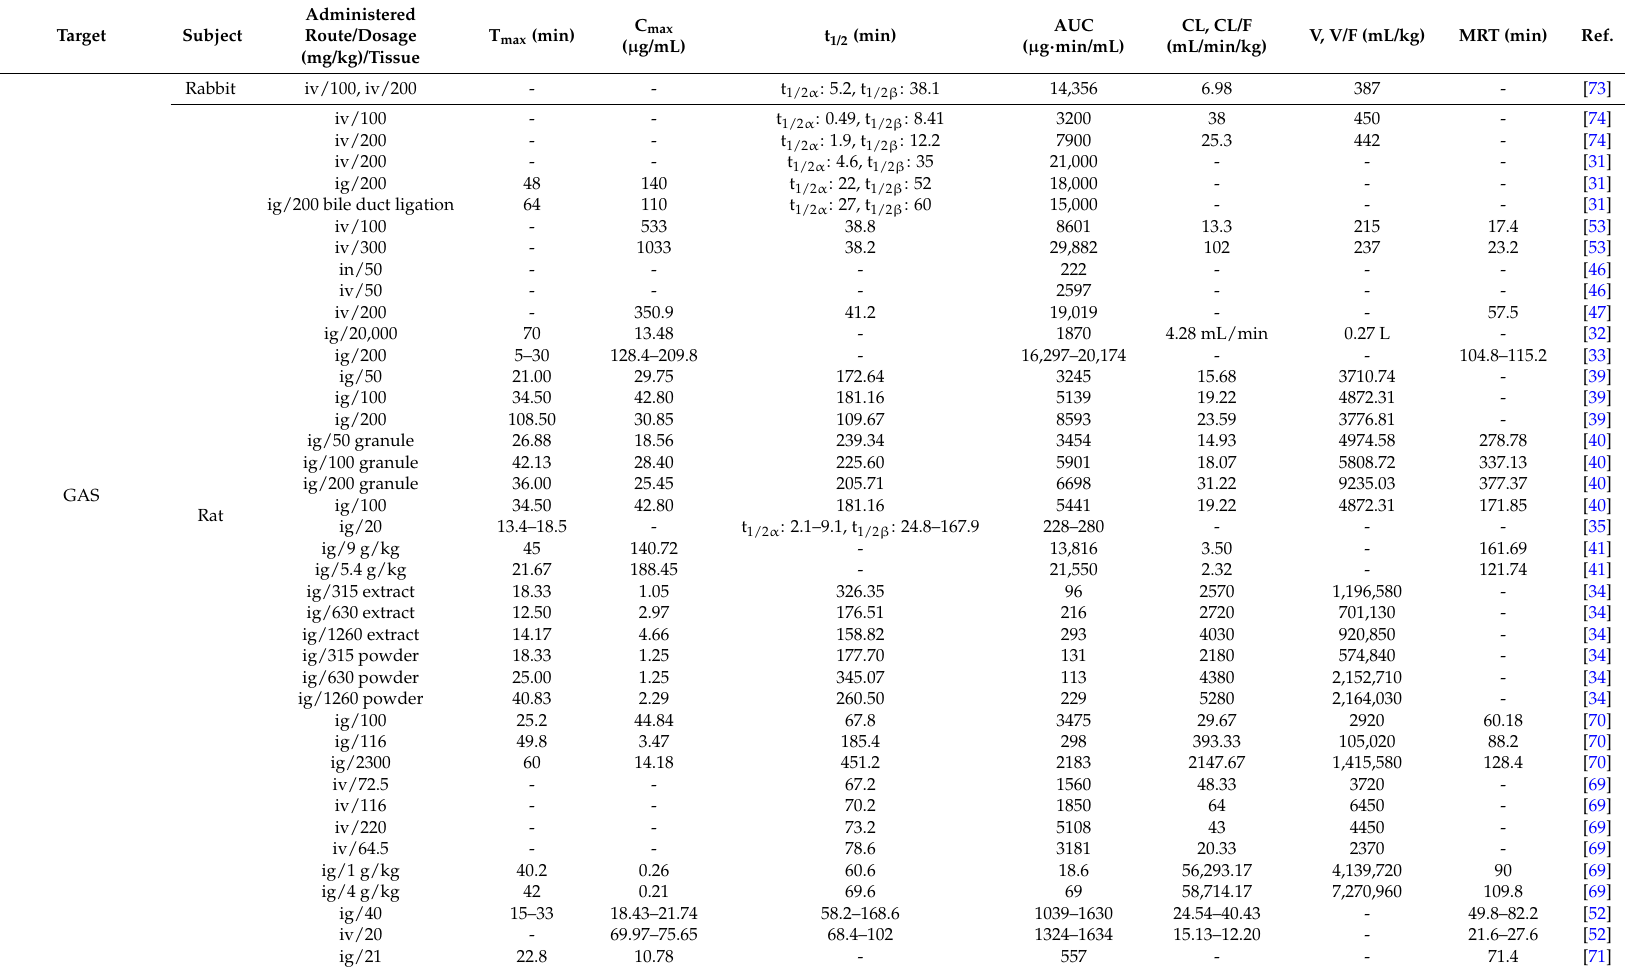
Table 2. Pharmacokinetic information of G. elata or its